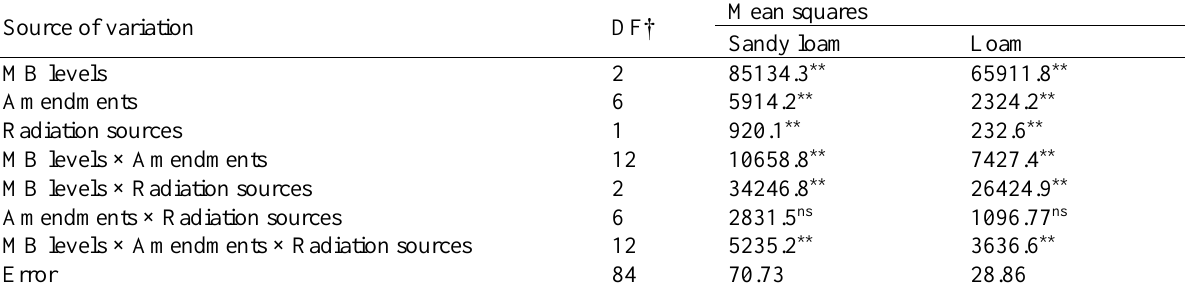
Table 2. A nalysis of variance of extracted methylene blue in sandy loam and loam soils affected by Cd levels and chelating agents Source of variation DF†